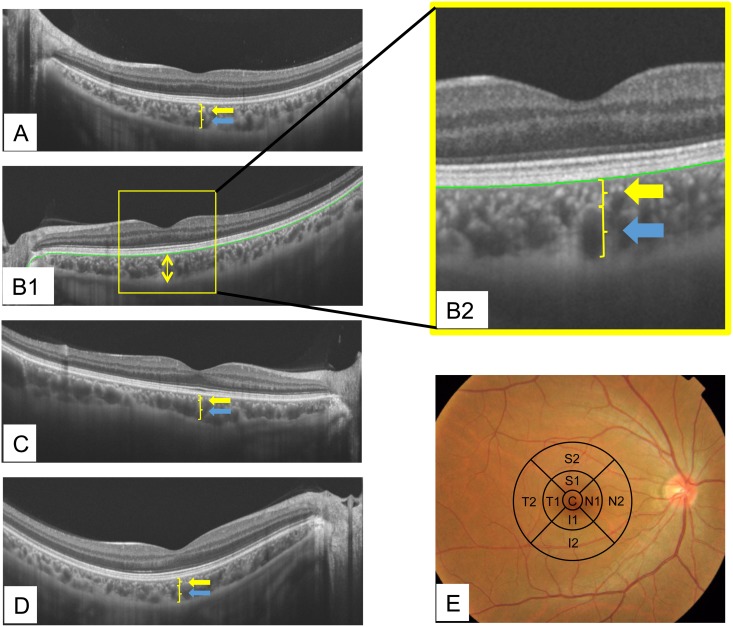
The choriocapillaris plus Sattler’s (CS) layer and the choroidal large vessel layer.(A-D) Choroidal thickness of each layer. The bold yellow arrow indicates the choriocapillaris plus Sattler’s layer, the bold blue arrow the choroidal large vessel layer. Total subfoveal choroidal thickness is the sum of these two layers (between the yellow and blue arrows). (B1) The green line represents the bottom of the RPE, the two yellow arrows the thickness of the subfoveal choroid. (B2) This image is the expanded image of the yellow square portion of B1. (E) Early Treatment Diabetic Retinopathy Study (ETDRS) macular map sectors. The central area represents the fovea. Mean macular thickness was calculated for the superior (S), inferior (I), temporal (T), and nasal (N) areas, all for diameters of 1 mm, 3 mm, and 6 mm. We defined ‘C’ as the “mean foveal choroidal thickness area”, and each of the other four areas as follows: ‘S1+S2 = mean superior choroidal thickness area’, ‘I1+I2 = mean inferior choroidal thickness area’, ‘N1+N2 = mean nasal choroidal thickness area’, and ‘T1+T2 = mean temporal choroidal thickness area’.